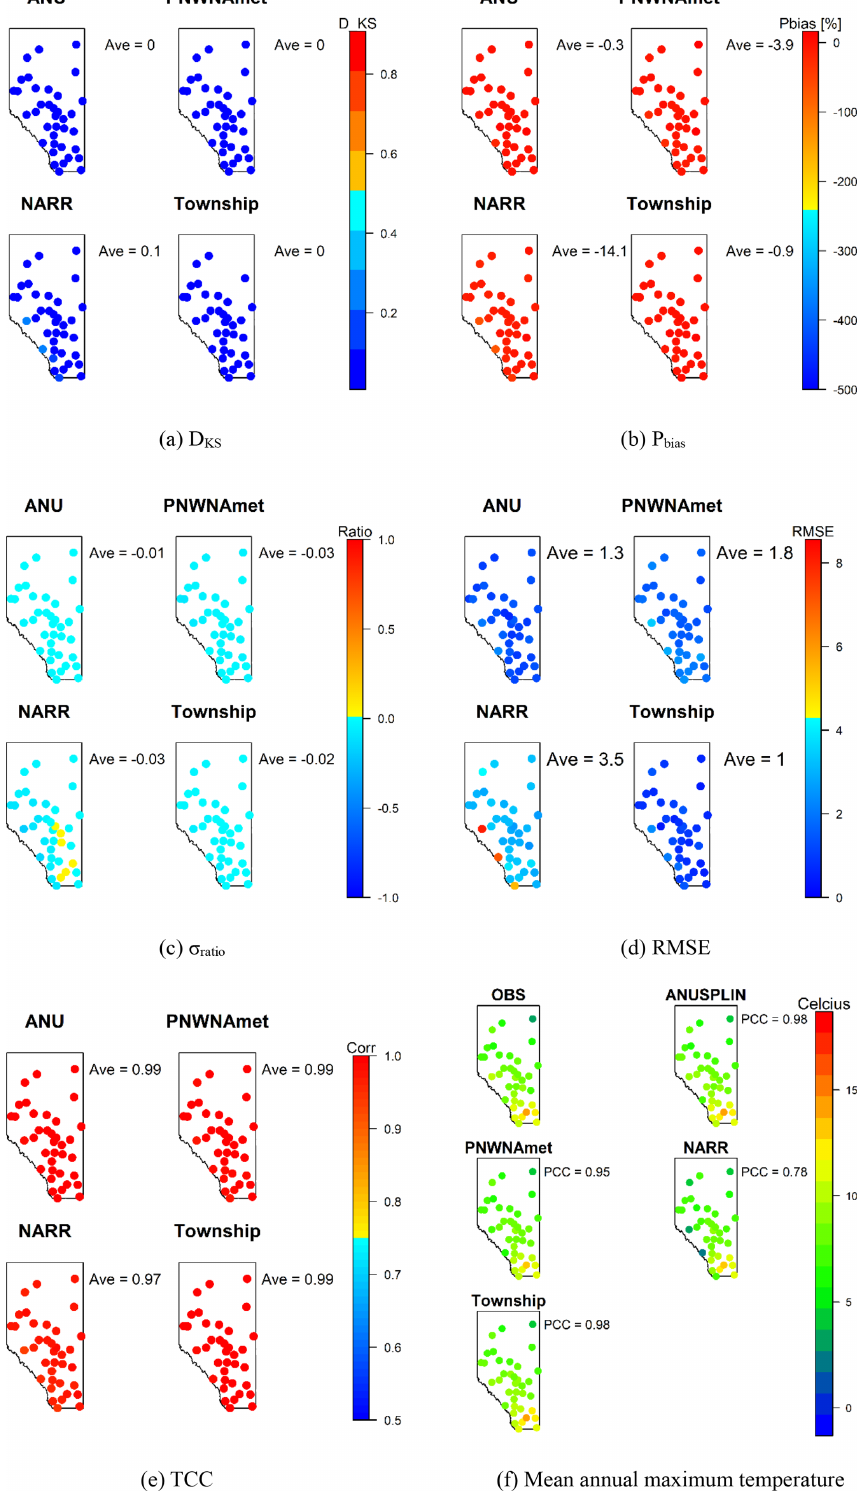
Figure 7. Maps of performance measures for maximum temperature over the AHCCD stations in Alberta. (a) D KS , (b) P bias , (c) σ ratio , (d) RMSE, (e) TCC, (f) mean annual maximum